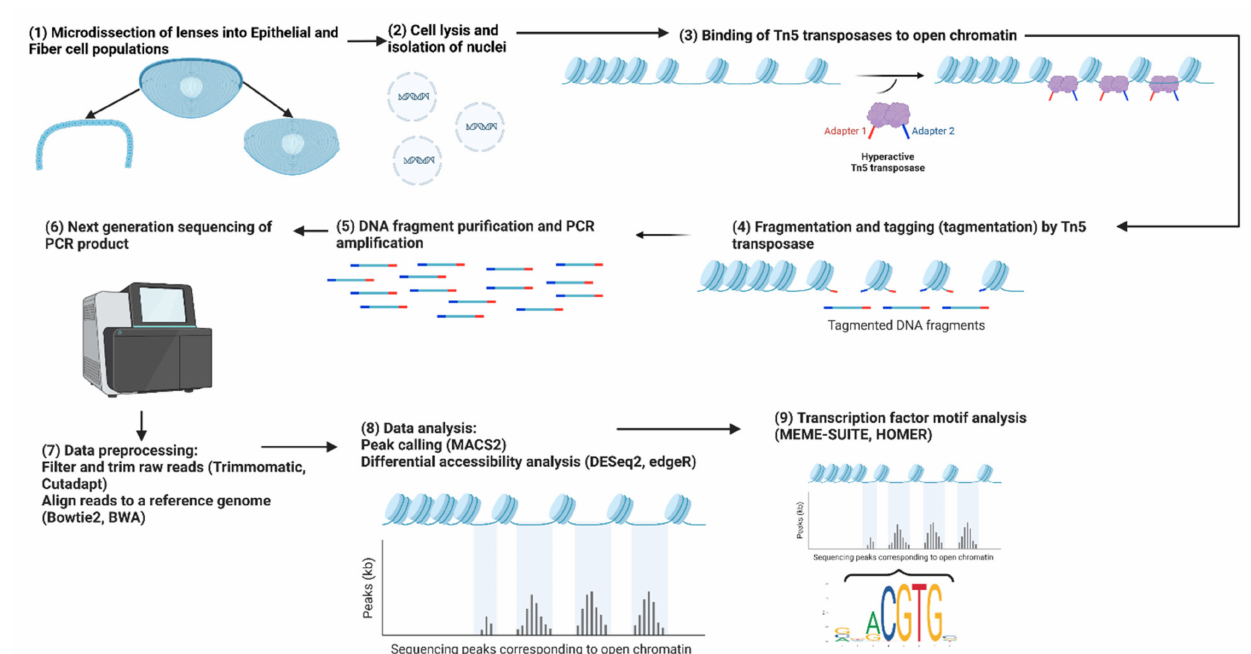
Figure 3. Workflow for an ATAC-seq experiment comparing lens epithelial cells and fiber cells. The figure depicts the step-by-step process of the ATAC-seq experiment, starting with the isolation of lens epithelial and fiber cells, followed by nuclei isolation, fragmentation and